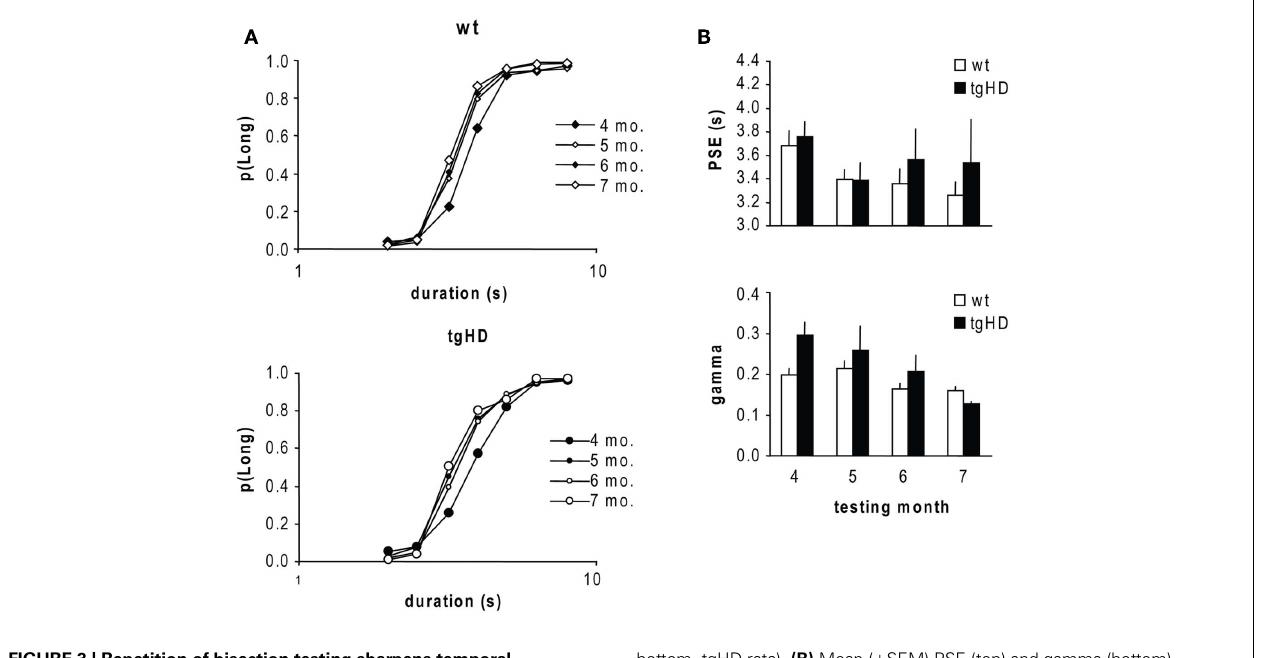
FIGURE 3 | Repetition of bisection testing sharpens temporal sensitivity. (A) Evolution of bisection curves for test months 4–7 for subgroups of animals that were responding at 7months (top, wt rats;